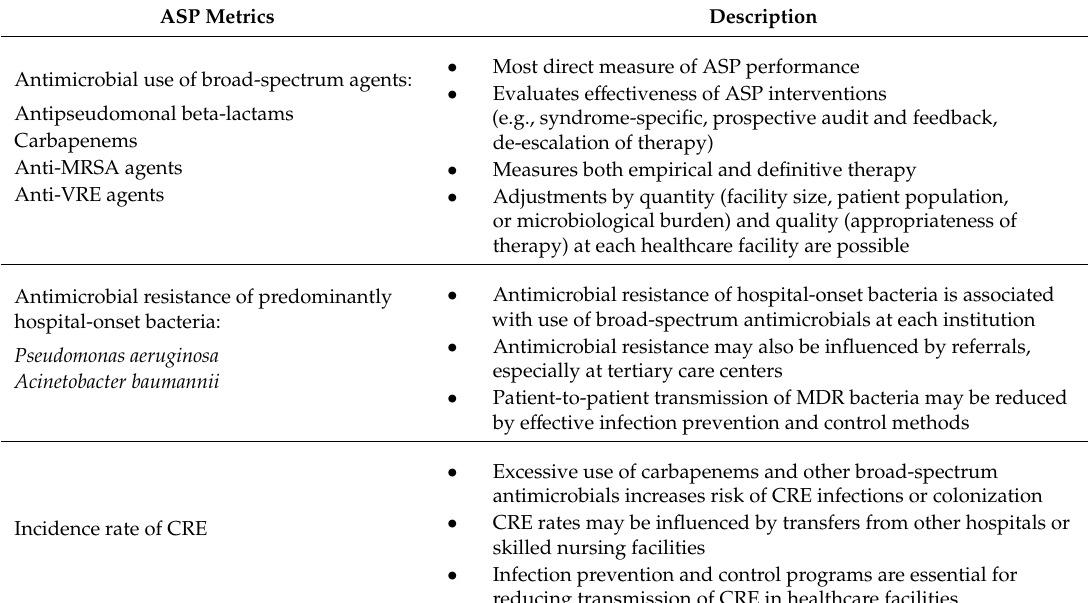
Table 4. Direct antimicrobial stewardship